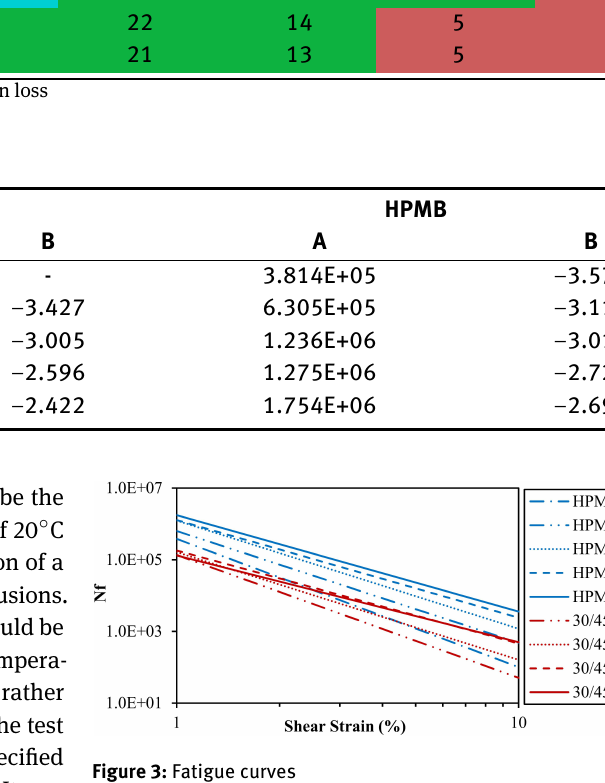
Table 5: Relationship between | G* | , test temperature and failure mechanism (based on [26]) Asphalt binder Replicate 10 ∘ C 15 ∘ C 20 ∘ C